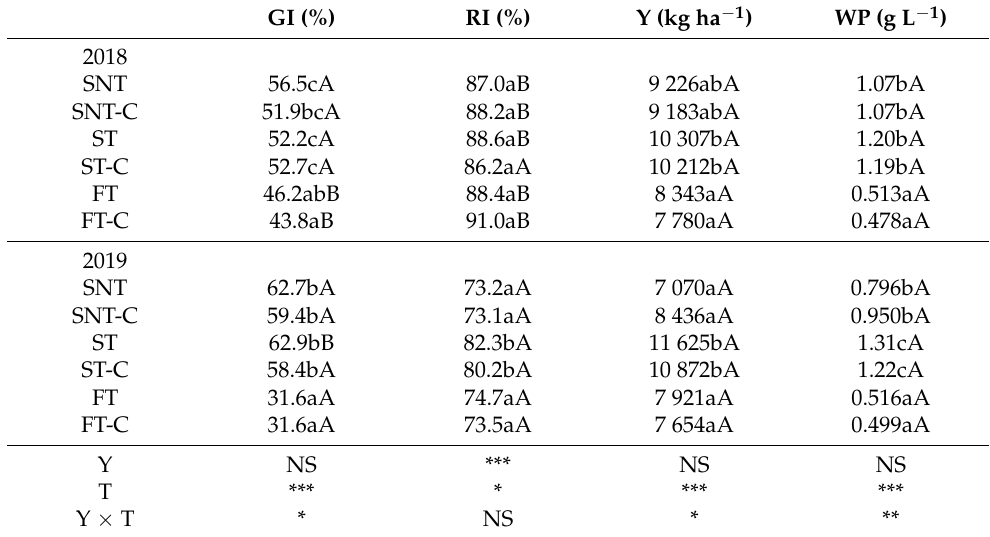
Table 1. Medium-term effects of different management systems on rice yield